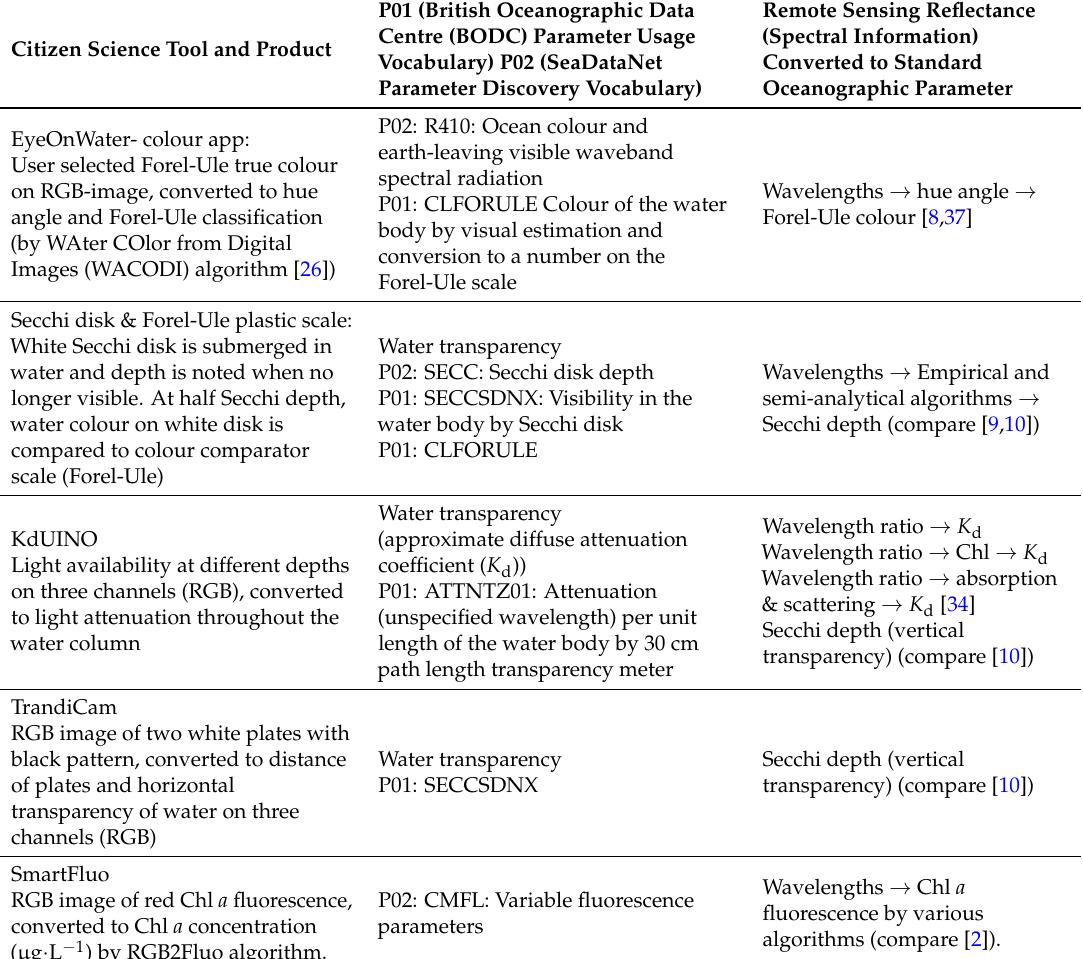
Table 2. Citizen science tools and standardized vocabulary for EU FP7 Citclops project parameters and their optical remote sensing